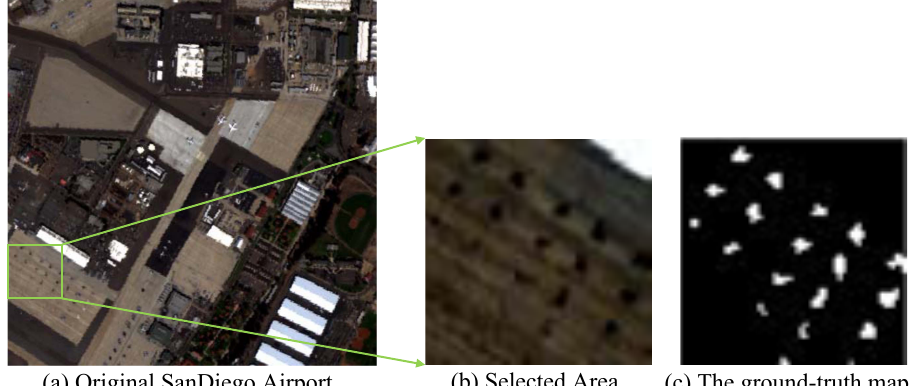
Figure 5. Sandiego60